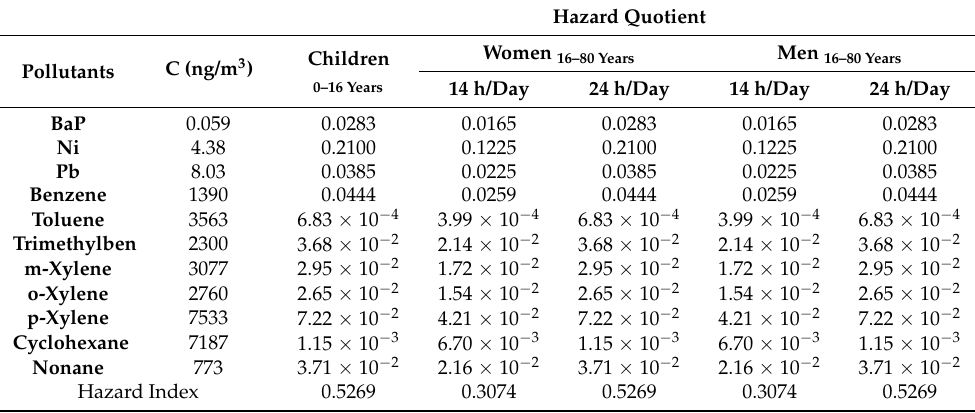
Table A9. Non-cancer risk assessment B.III method (Chalvatzaki,